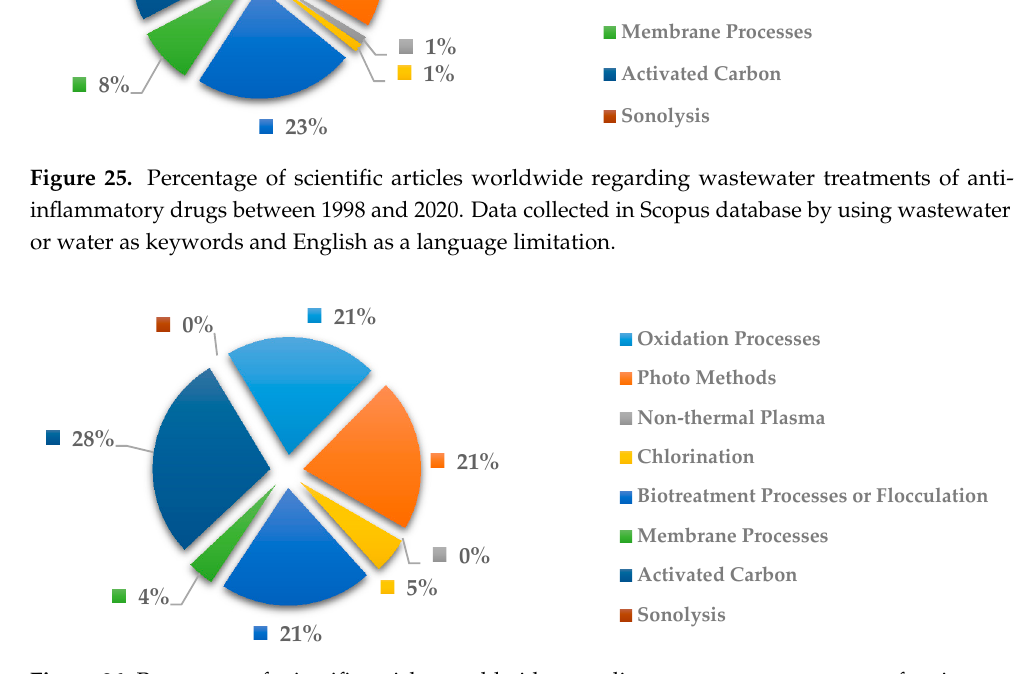
Figure 26. Percentage of scientific articles worldwide regarding wastewater treatments of anticancer drugs between 1998 and 2020. Data collected in Scopus database by using wastewater or water as keywords and English as a language limitation.